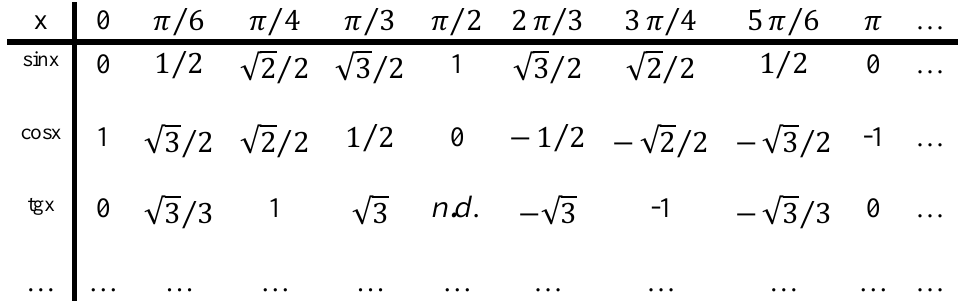
Table 2.2 Values assumed by common angles where “ n.d .” is “ not define